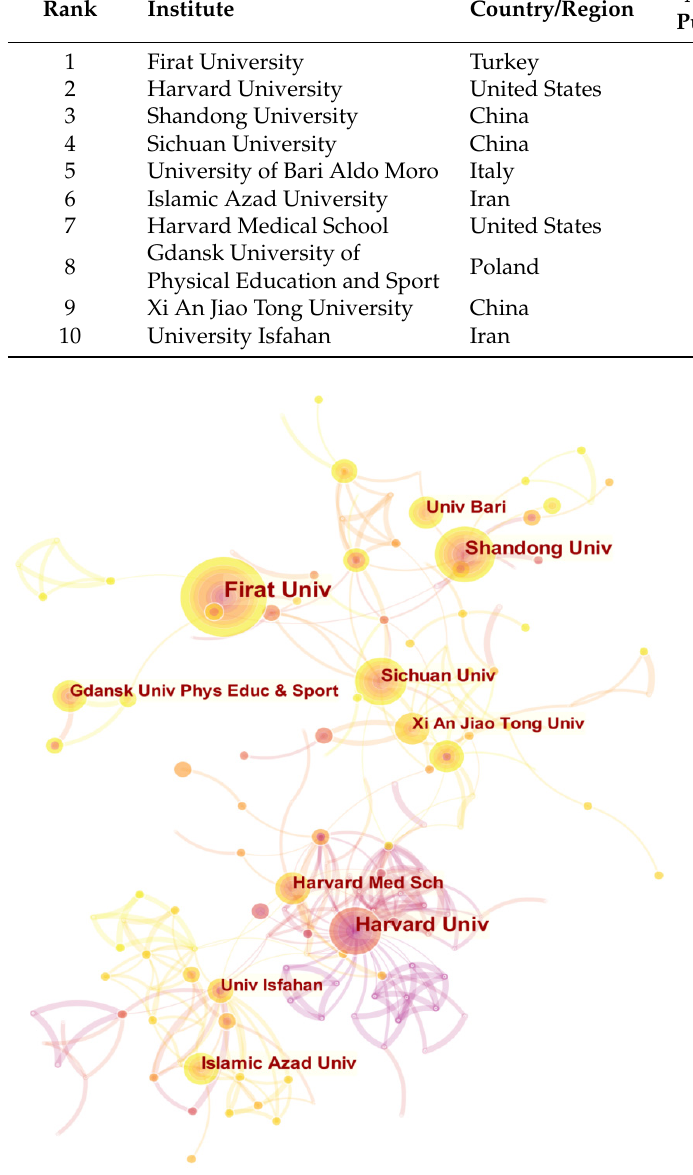
Figure 4. Co-occurrence knowledge map of irisin research institutions. Here, each node represents a scientific research institution, and the size of the node represents the number of published papers of the institution. Table 2. High yield institution information of irisin research.